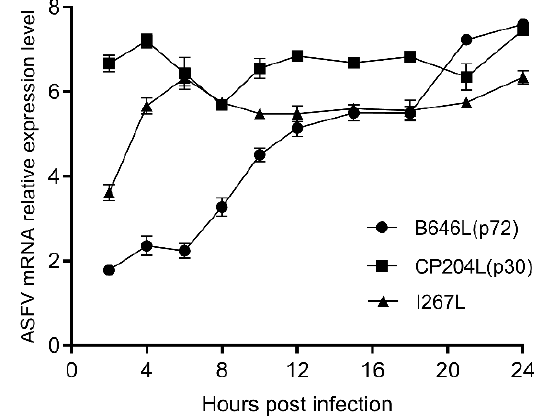
Figure 2. The relative expression levels of mRNA of I267L CP204L and B646L . The relative expression level of mRNA of I267L , CP204L , and B646L genes were quantified between BMDMs infected with SY18 and mock-infected BMDMs. The values of Y axis were expressed by the base-10 logarithm (log 10 ) of the relative expression level.